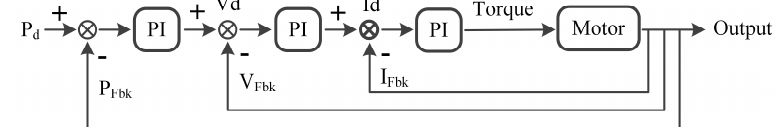
Figure 4. Schematic of the PI parameter adjustment process.